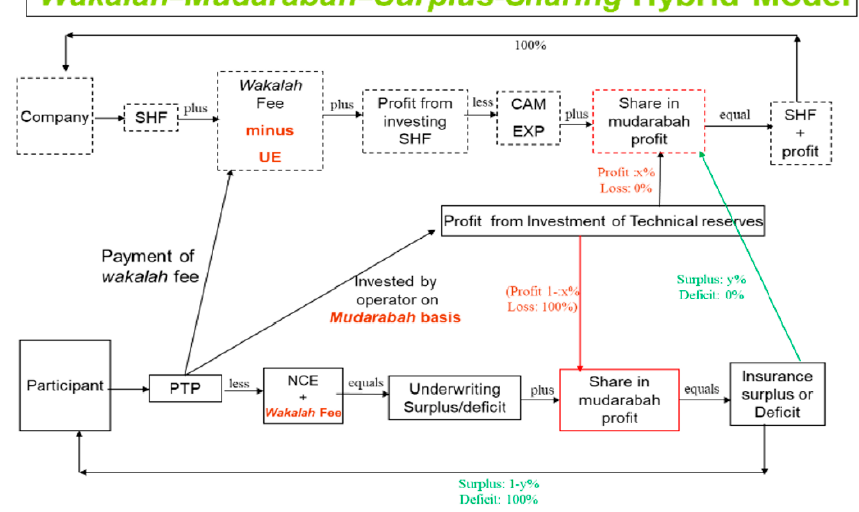
Figure 6. Wakalah–Mudarabah–Surplus-Sharing hybrid operational model of takaful.